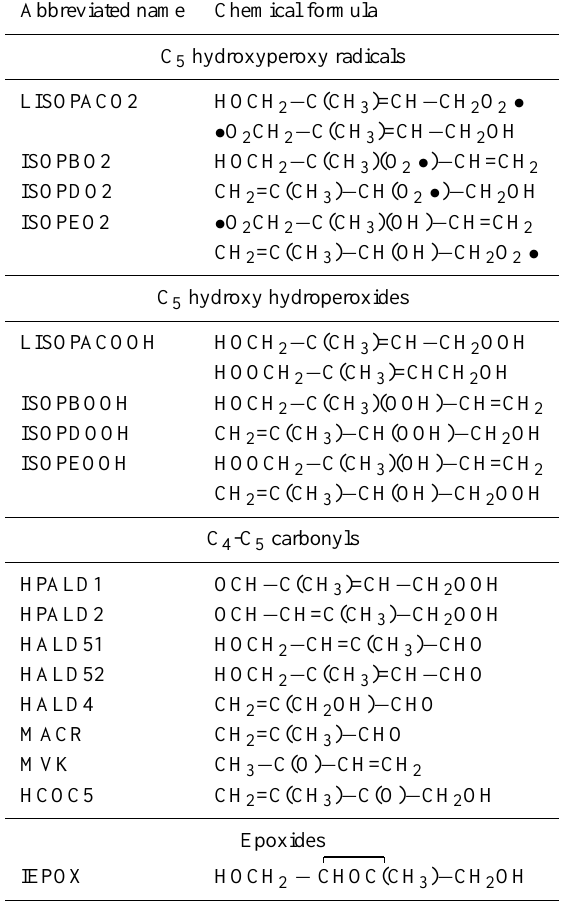
Table 1. Abbreviated name and chemical formula (Lewis structure) of isoprene degradation products appearing in this